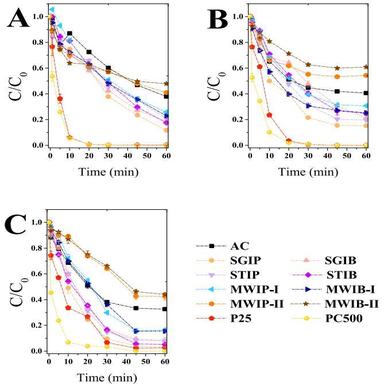
Removal of caffeine (A), saccharin (B), and sucralose (C) by the TiO2/ AC heterostructures, pristine AC under UV-C, TiO2–P25, and TiO2-PC500 (8 W) irradiation. Initial concentration of the contaminants = 2 mg L− 1 and TiO2/AC heterostructure = 25 mg L− 1 .